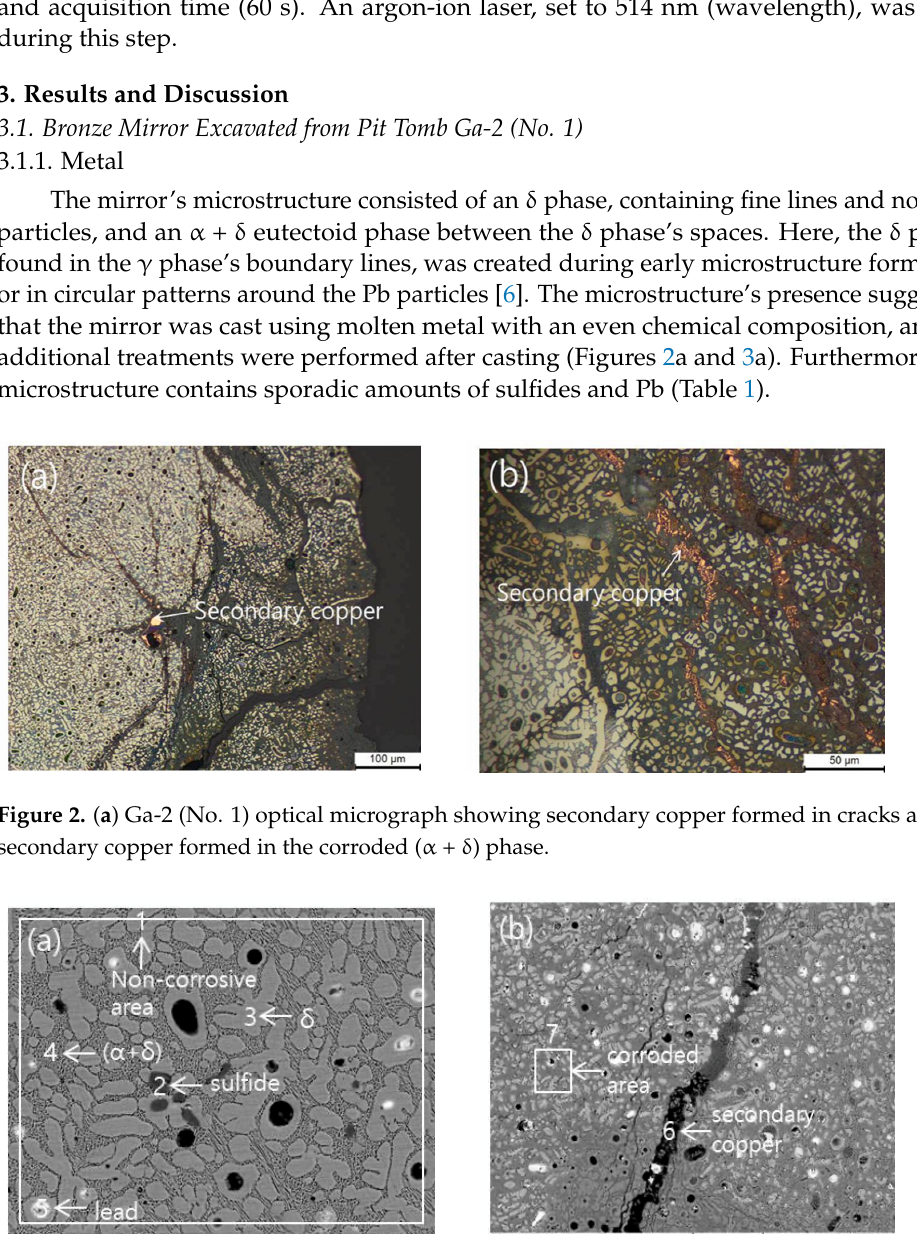
Figure 3. Ga-2 (No. 1) scanning electron microscope-energy dispersive spectrometer (SEM-EDS) image. ( a ) Original microstructure without corrosion and ( b ) secondary copper grains in corroded microstructures and cracks.